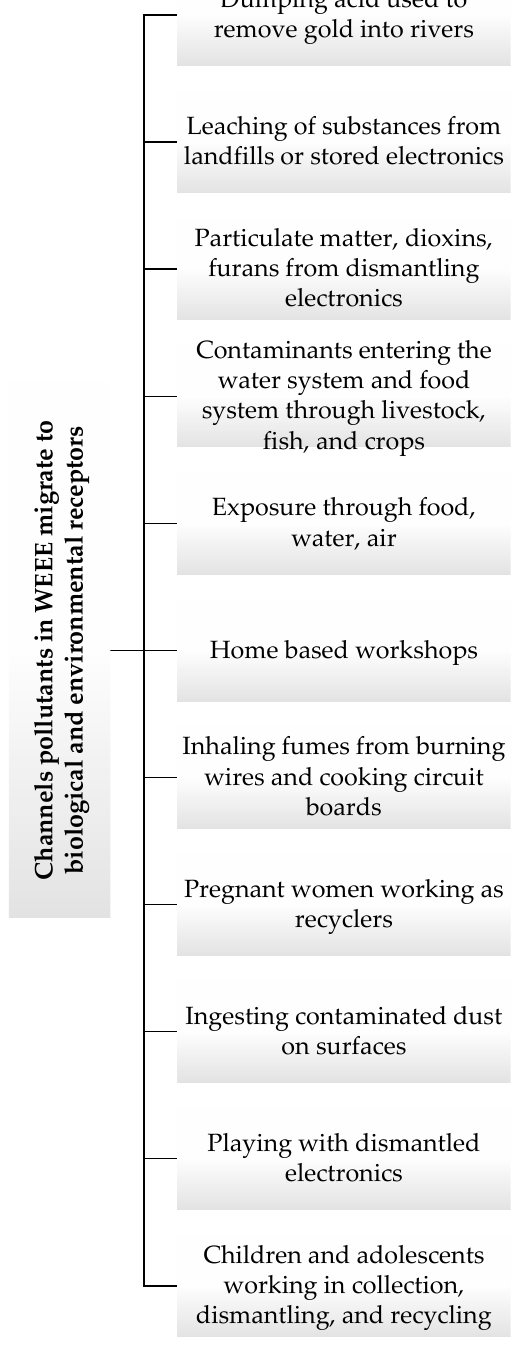
Figure 1. Channels pollutants in WEEE migrate to biological and environmental receptors.